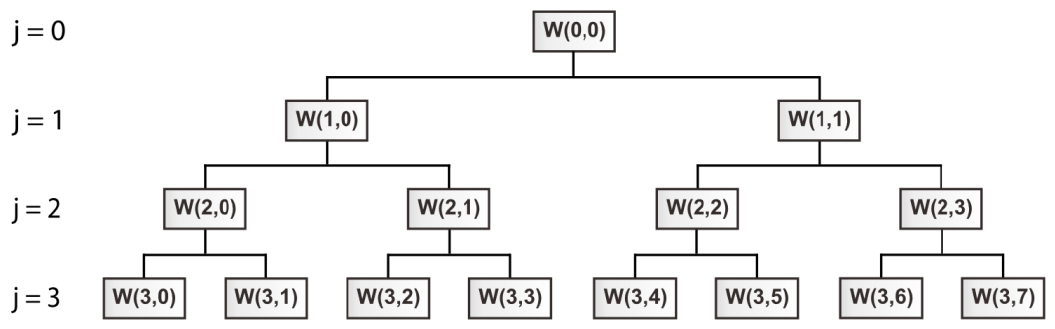
Figure 5. WPT tree scheme.